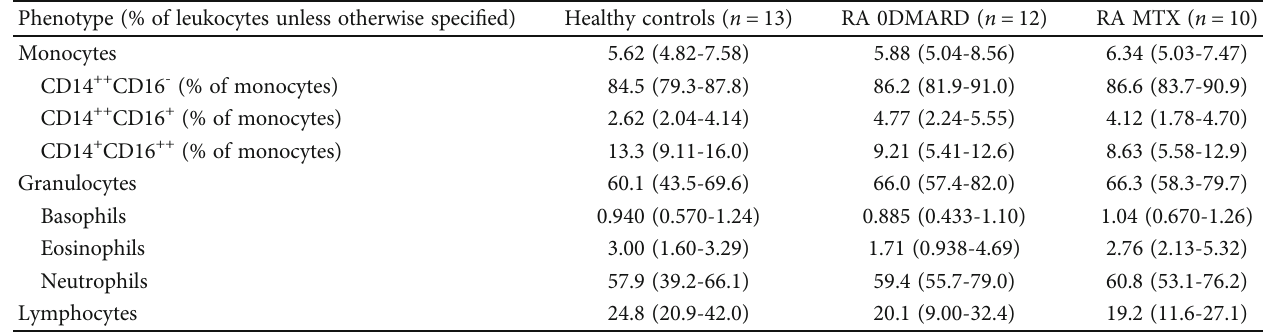
Table 2: Frequencies of circulating leukocytes in RA patients and HC, at baseline.